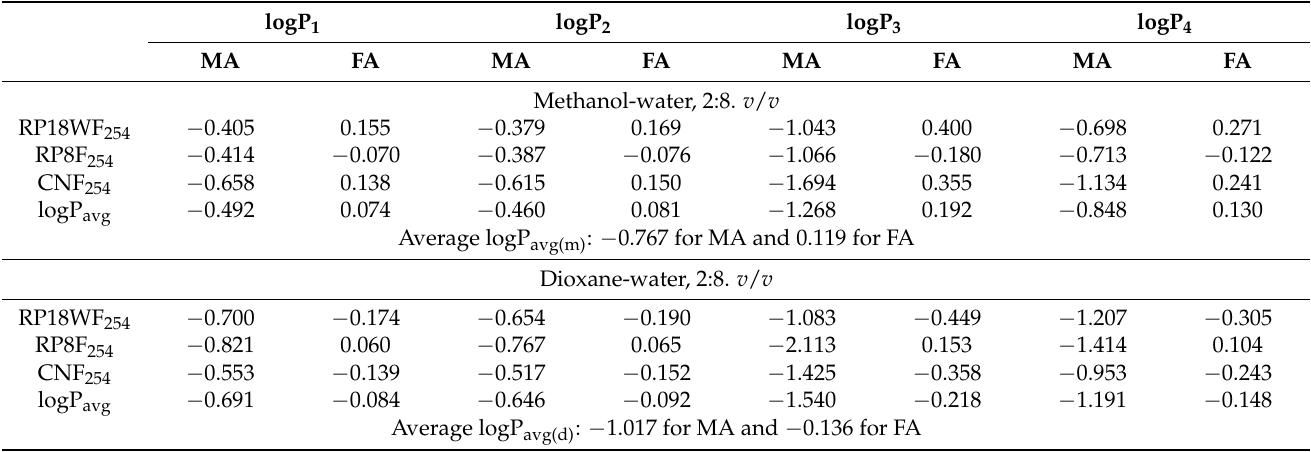
Table 6. LogP calculated using Equations (5)–(8) at the application of the topological indices and the R M values for maleic acid (MA) and fumaric acid (FA).